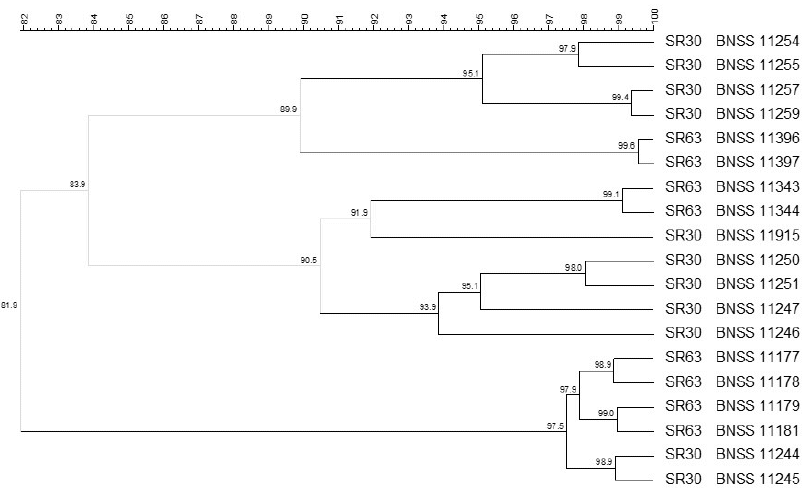
Figure 5. UPGMA cluster analysis, using Pearson correlation, of (GTG) 5 rep-PCR fingerprints of 19 Enterococcus faecium isolates from SR30 and SR63 natural cultures. For each isolate, the indication of the culture (30 or 63) and the BNSS ID were reported.